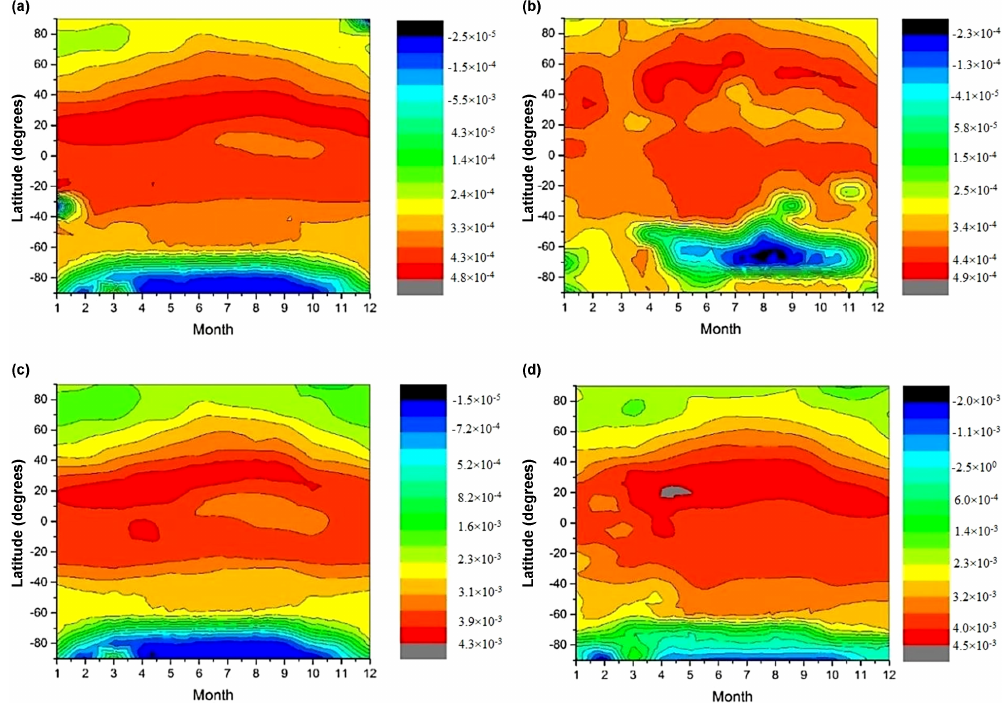
Figure 6. Contour plots for radiative forcing (Wm − 2 ) by latitude and month for (a) instantaneous radiative forcing of NF 3 , (b) stratospheric adjusted radiative forcing of NF 3 , (c) instantaneous radiative forcing of CFC-115 and (d) stratospheric adjusted radiative forcing of CFC-115. Note different contour intervals between panels.